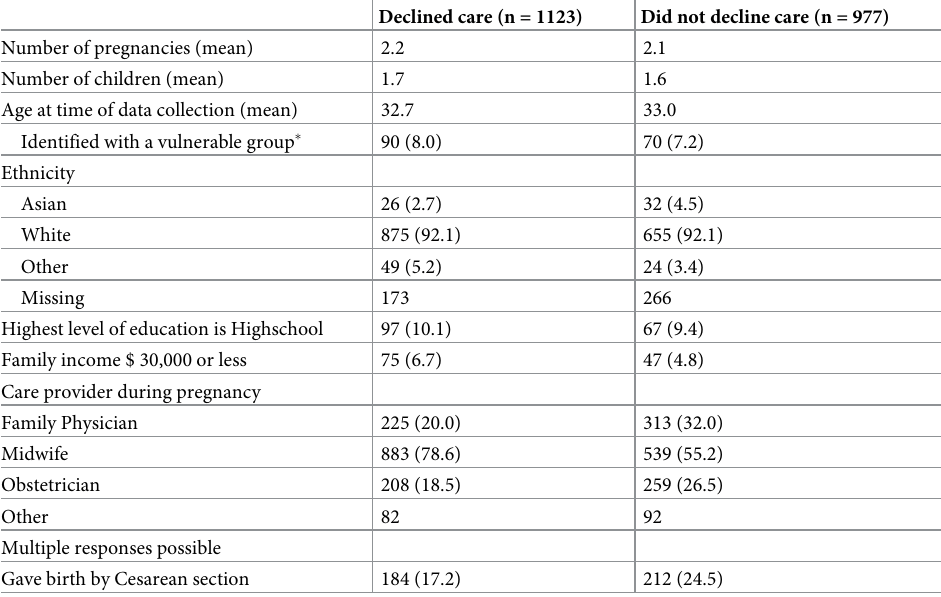
Table 2. Characteristics of childbearing people who declined care and provided open-ended comments (n = 2100). Declined care (n = 1123) Did not decline care (n =